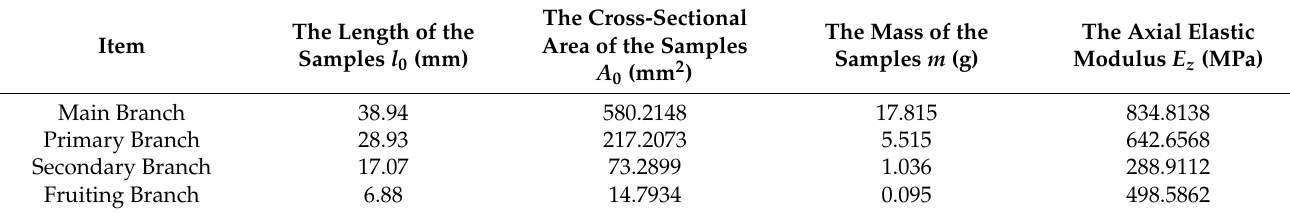
Table A2. The parameters of the branches in the axial compression tests.